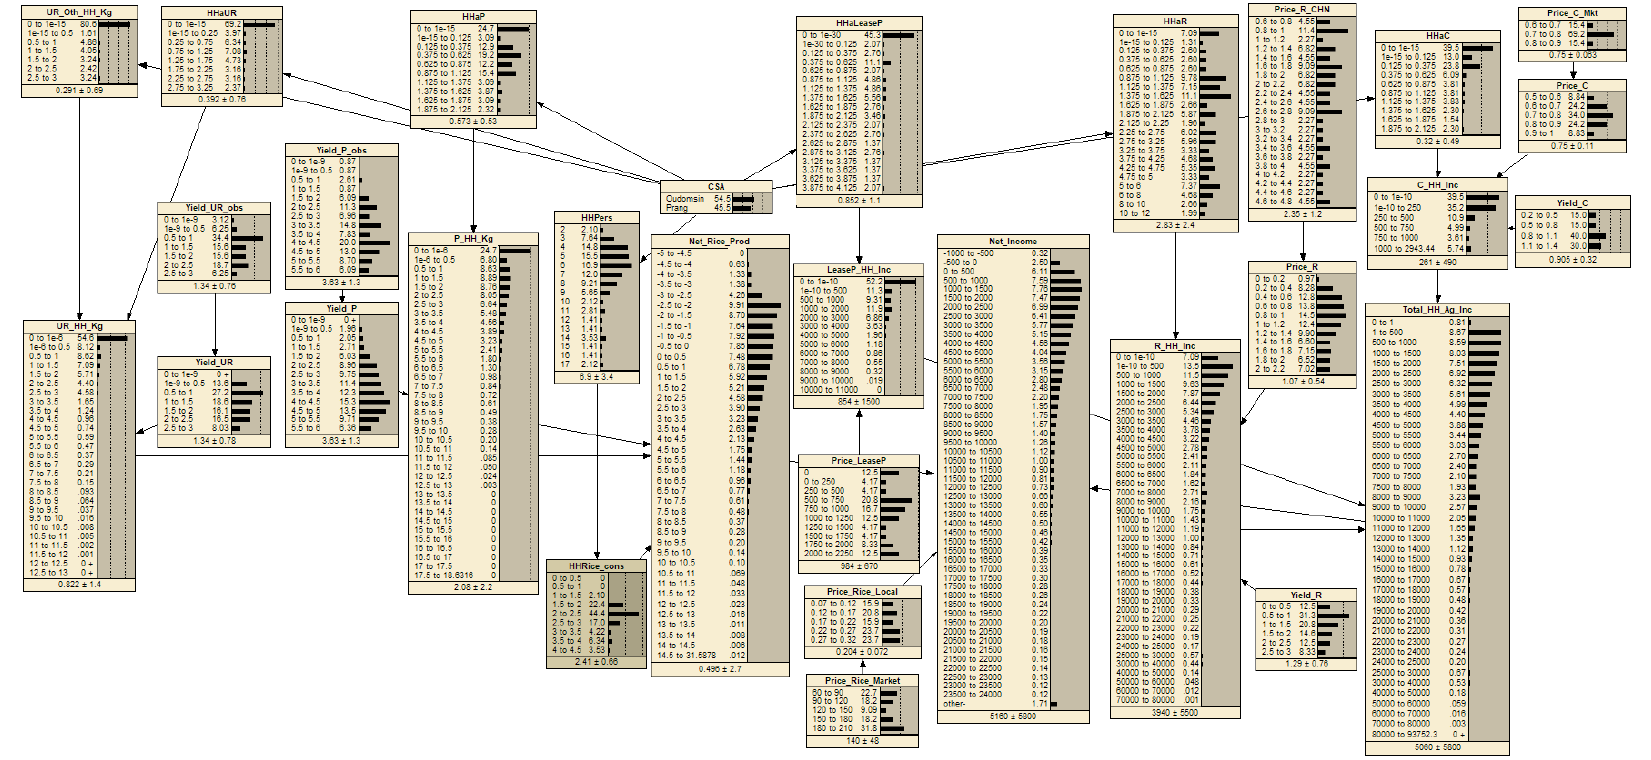
Figure A1.2: Bayesian network model. Details are shown on the next two